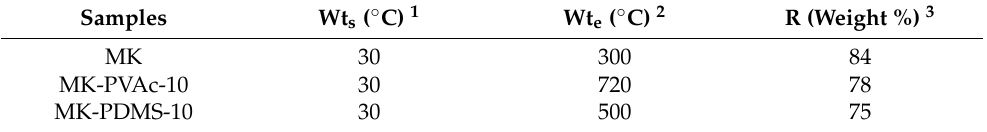
Table 3. Thermal properties of the neat geopolymer MK, MK-PVAc-10, and MK-PDMS-10 samples.